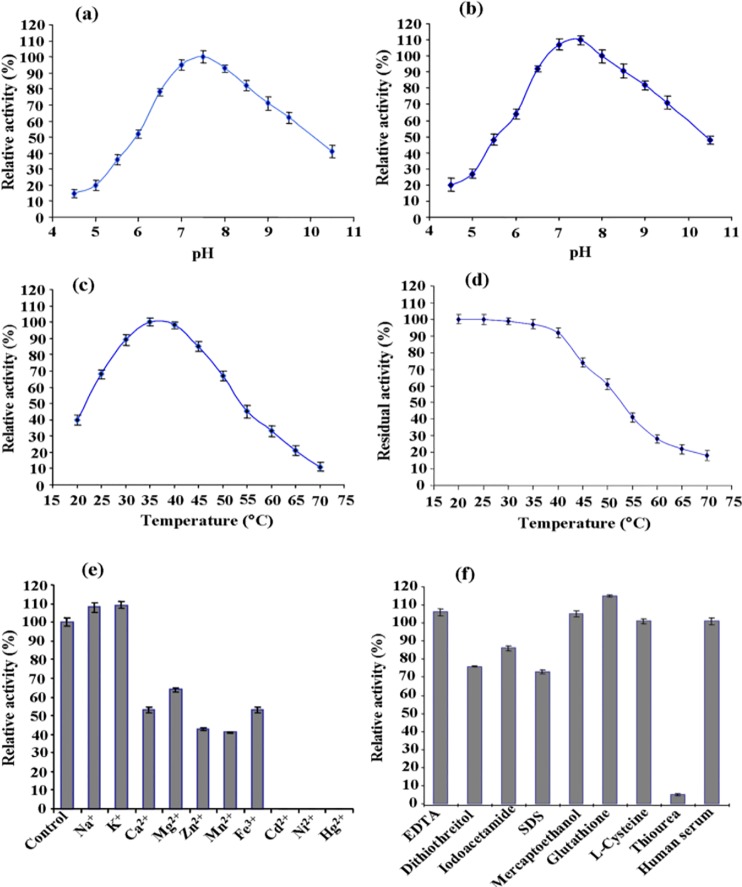
Biochemical properties of asparaginase purified from E. cloacae.Optimum pH (a) and pH stability of asparaginase (b) were determined by assessing the enzyme activity in the pH range of 4.5–10.5 with various pH buffers as follows: pH 4.5–7.5, 50 mM Potassium phosphate buffer; pH 8.0–10.5, 50 mM Tris-HCl buffer. Optimum temperature on the activity (c) and the thermostability of asparaginase (d) were determined at various temperatures (20–70°C). Effect of various metal ions (e) and modulators (f) on the asparaginase activity. Asparaginase was mixed with the corresponding metal salts (NaCl (50 mM), (KCl (150 mM), (CaCl2 (150 mM), (MgCl2 (40 mM), (ZnCl2 (100 mM), (MnCl2 (100 mM), (FeCl3 (100 mM), (CdCl2 (10 mM), (NiCl2 (10 mM), (HgCl2 (100 mM) or modulators EDTA (5 mM), DDT (5 mM), iodoacetamide (5 mM), SDS (2 mM), 2-mercaptoethanol (0.5 mM), glutathione (0.5 mM), L-cysteine (25 mM), thiourea (1 mM), and human serum (10%) in 50 mM phosphate buffer (pH 7.5) for 30 min at 37°C and enzyme activity was measured by Nesslerization reaction. No addition was used as control. Each value represents the mean ±SD for three determinations.